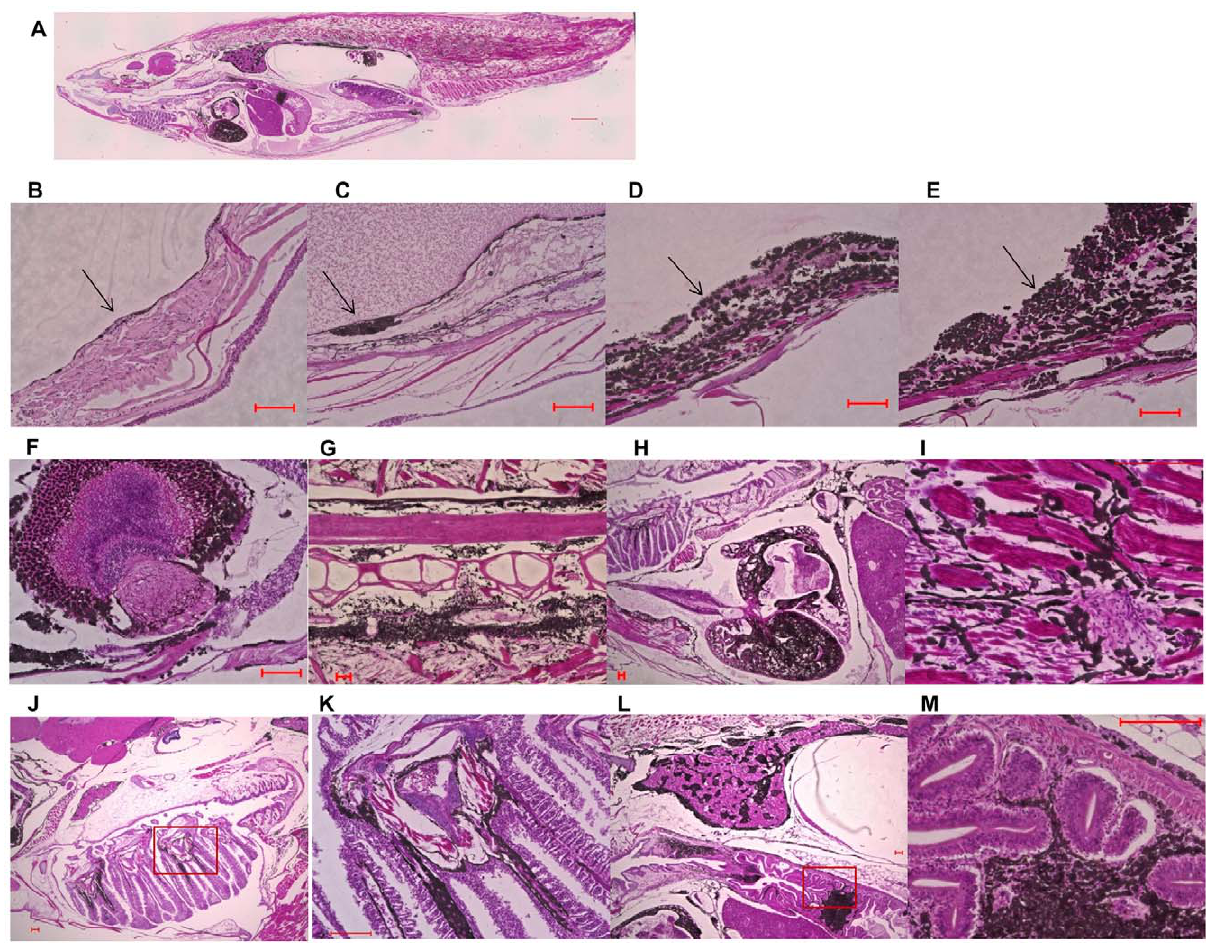
Figure 4. Hematoxylin-eosin staining of Tg ( tyr:HRAS G12V ) / Tg ( hsp:cre ) medaka. ( A ) Overall image of fish # 7 in Figure 3. ( B )– ( E ), Melanophore layers (arrows) of a wild-type adult fish ( B ) as well as of fish # 7 ( C ), # 6 ( D ), and # 4 ( E ) in Figure 3. ( F )– ( J ), Eye, bone and spinal cord, heart, muscle, and gill, respectively, of fish # 7 in Figure 3. ( K ) Enlarged image of the boxed region in ( J ). ( L ) Kidney and digestive duct of fish # 7 in Figure 3. ( M ) Enlarged image of the boxed region in ( L ). Scale bars: 1 mm ( A ) and 0.1 mm ( B – M ).